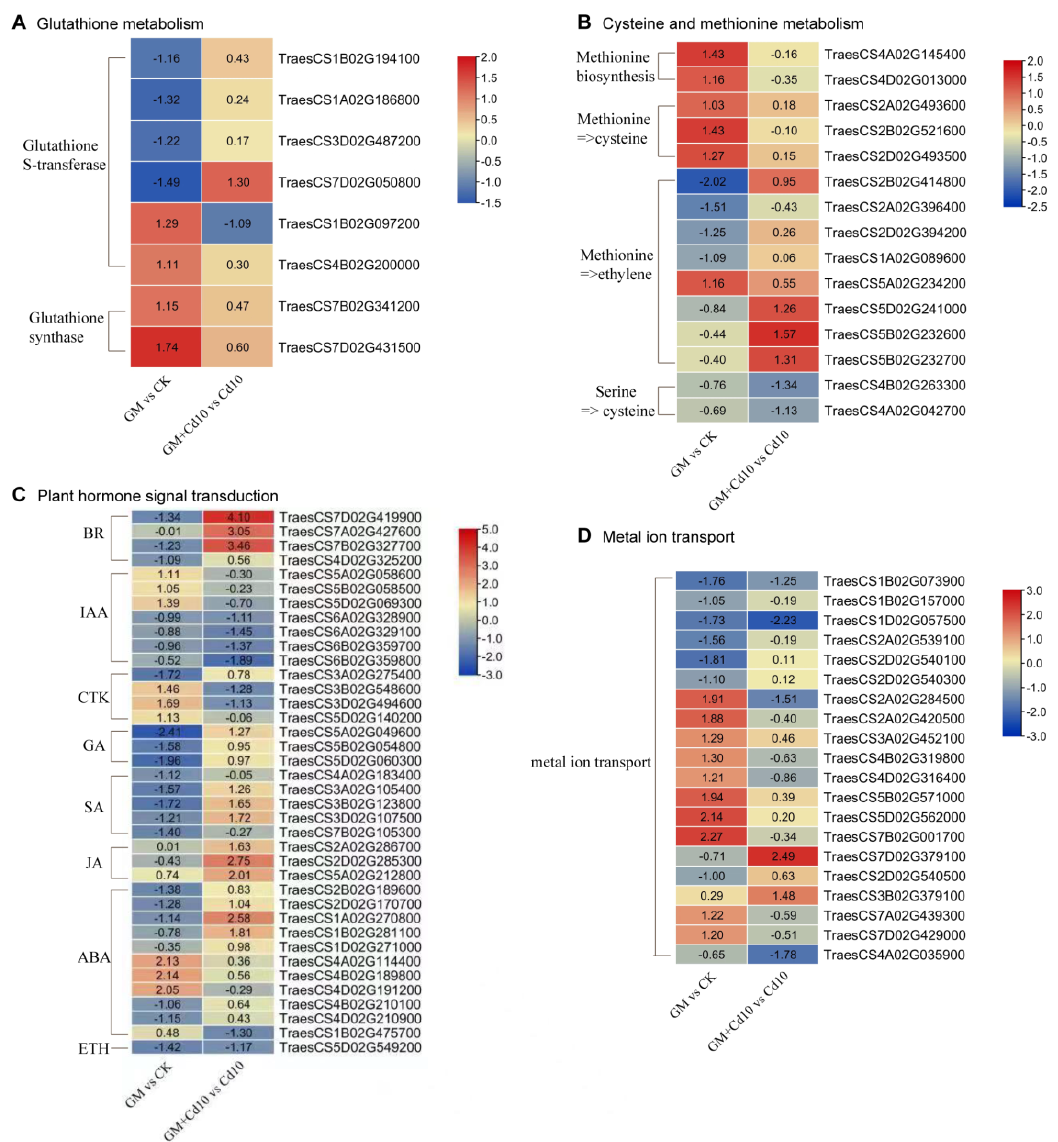
Figure 7. The DEGs mediating Glutathione metabolism ( A ), Cysteine and methionine metabolism ( B ), Plant hormone signal transduction ( C ) and Metal ion transport ( D ) in GM vs CK or GM+Cd10 vs Cd10 comparison groups. CK: Control group; GM: Inoculated with Glomus mosseae under normal conditions; Cd10: 10 mg·kg − 1 CdCl 2 treatment; GM+Cd10: Inoculated with Glomus mosseae under 10 mg·kg − 1 CdCl 2 treatment.